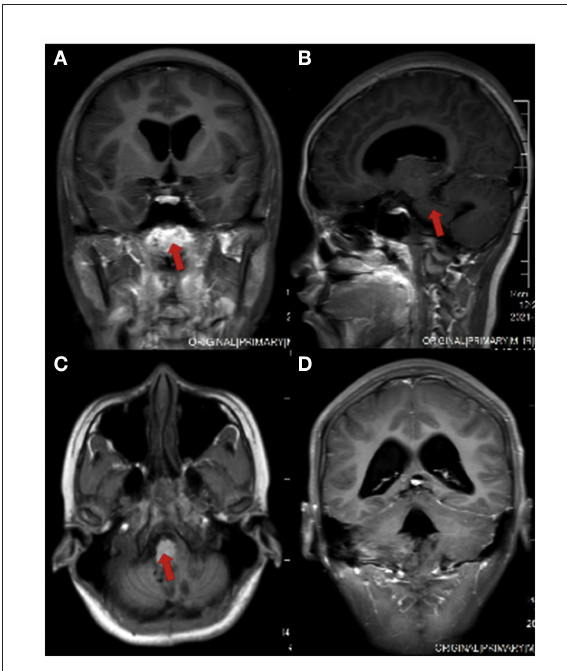
FIGURE1 Head MRI of the patient before surgery. (A) coronal view; (B) sagittal section view; (C) axial view; (D) ventricular enlargement in coronal view